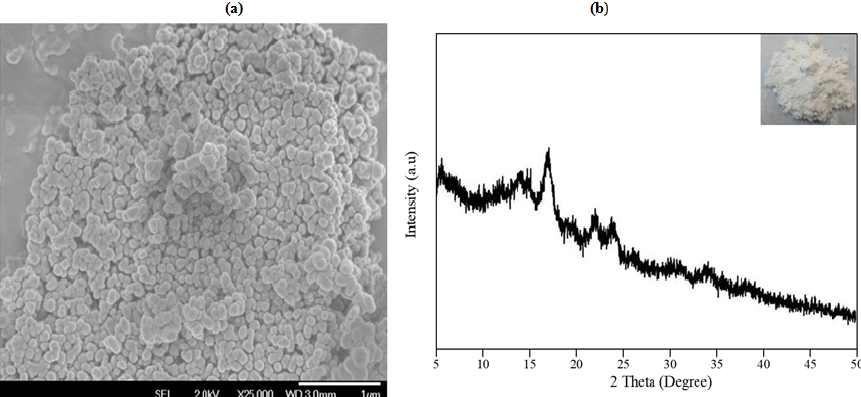
Figure 3. ( a ) The FESEM micrograph of potato starch; and ( b ) The XRD diffractogram of potato starch. Inset represents a photograph image of starch powder.